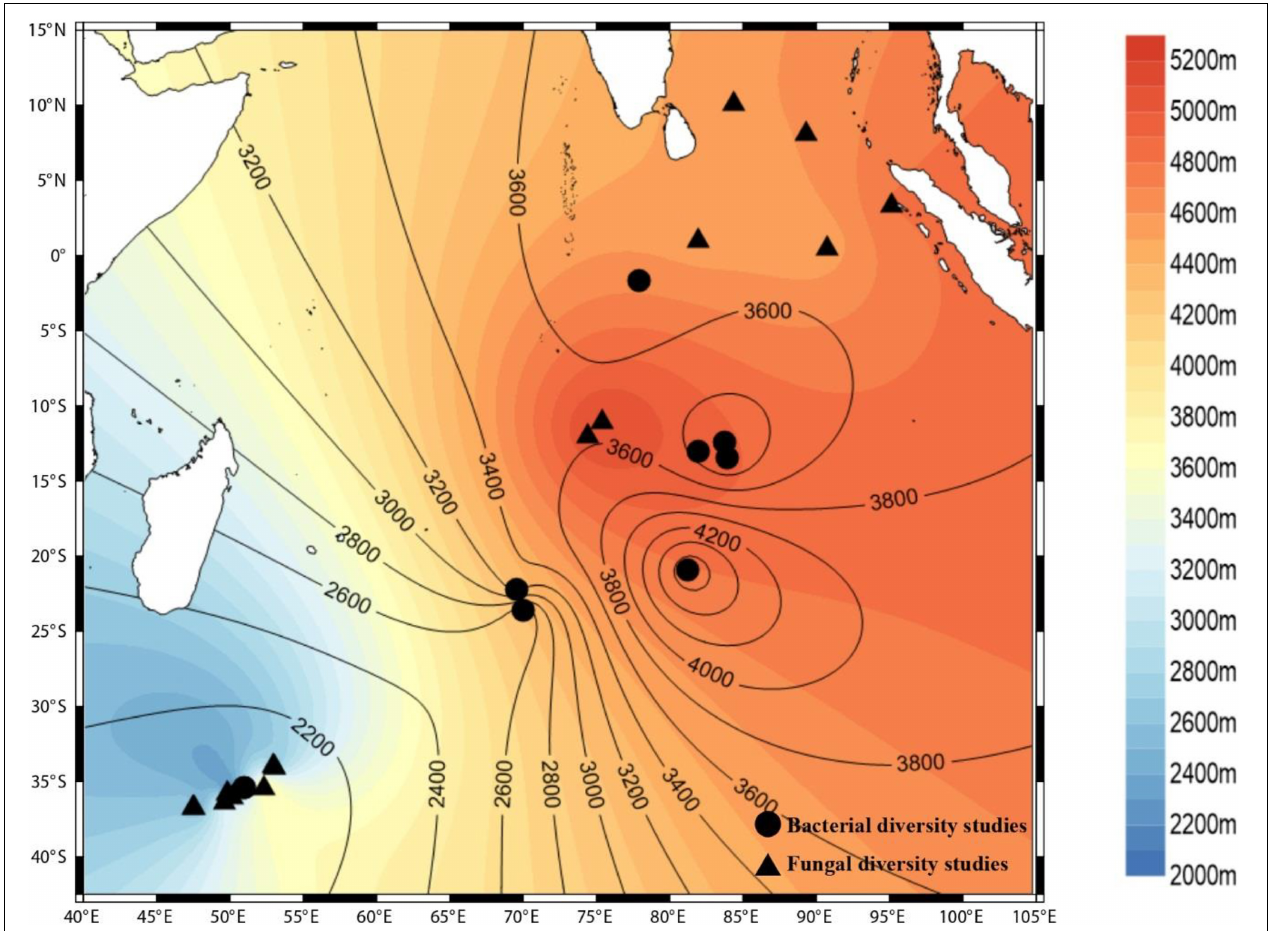
FIGURE 1 | Culture-independent studies carried out at various locations in the Indian Ocean. The circles depict the bacterial diversity studies; the triangles depict the fungal diversity studies. (Surfer, Golden software LLC).